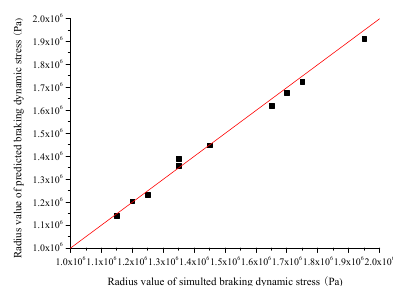
Figure 17. Radius results between prediction and simulation.